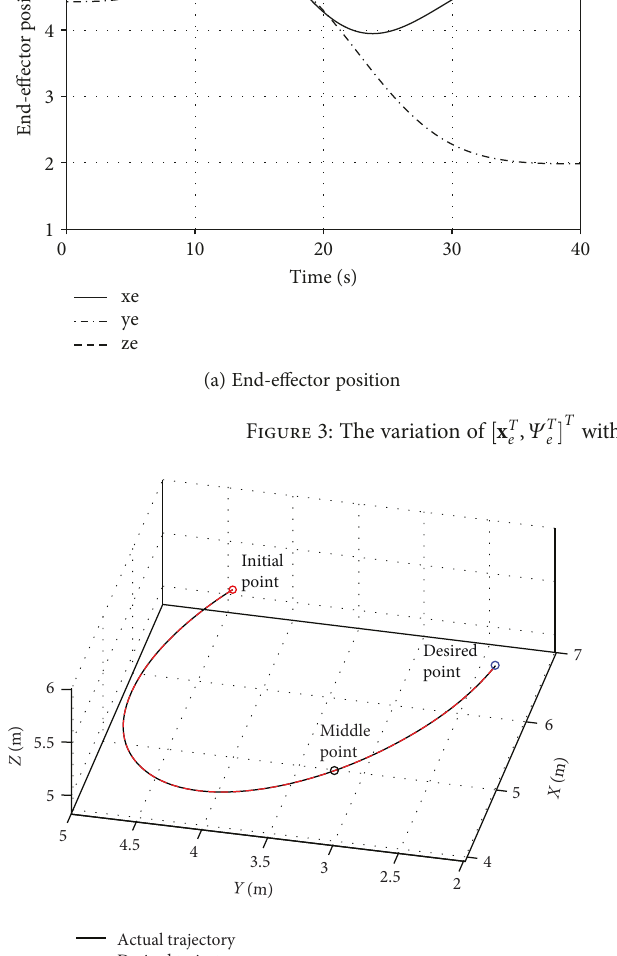
Figure 4: Comparison between the actual and desired end-e ff ector